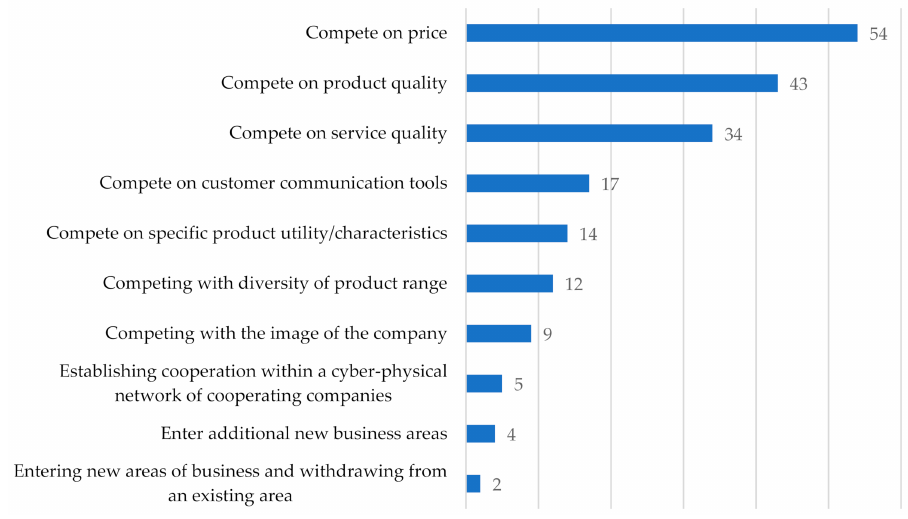
Figure 13. Achieved benefits thanks to implementation of Industry 4.0 pillars.